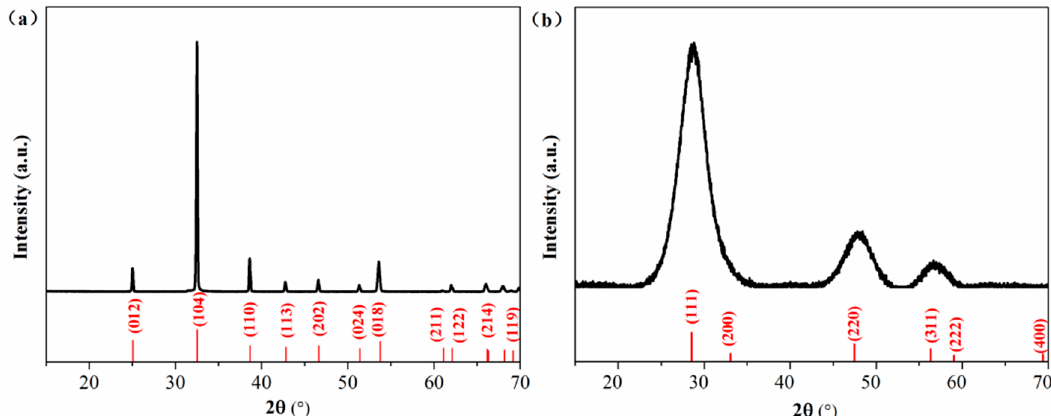
Figure 1. XRD patternsfor ( a ) the smithsonite sample and ( b ) synthetic sphalerite ZnS. Measured XRD patterns and JCPDS patterns were plotted in black and red, respectively.